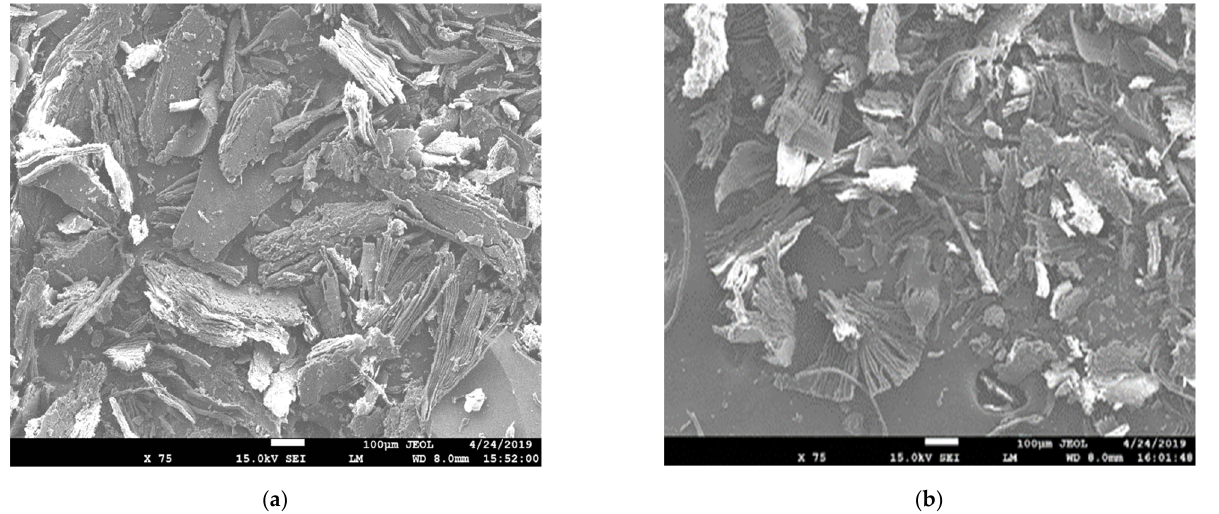
Figure 4. FE-SEM photograph of Fe ӀӀӀ -CS-GLA before ( a ) and after ( b ) its use in the catalytic degra- dation of CPF.